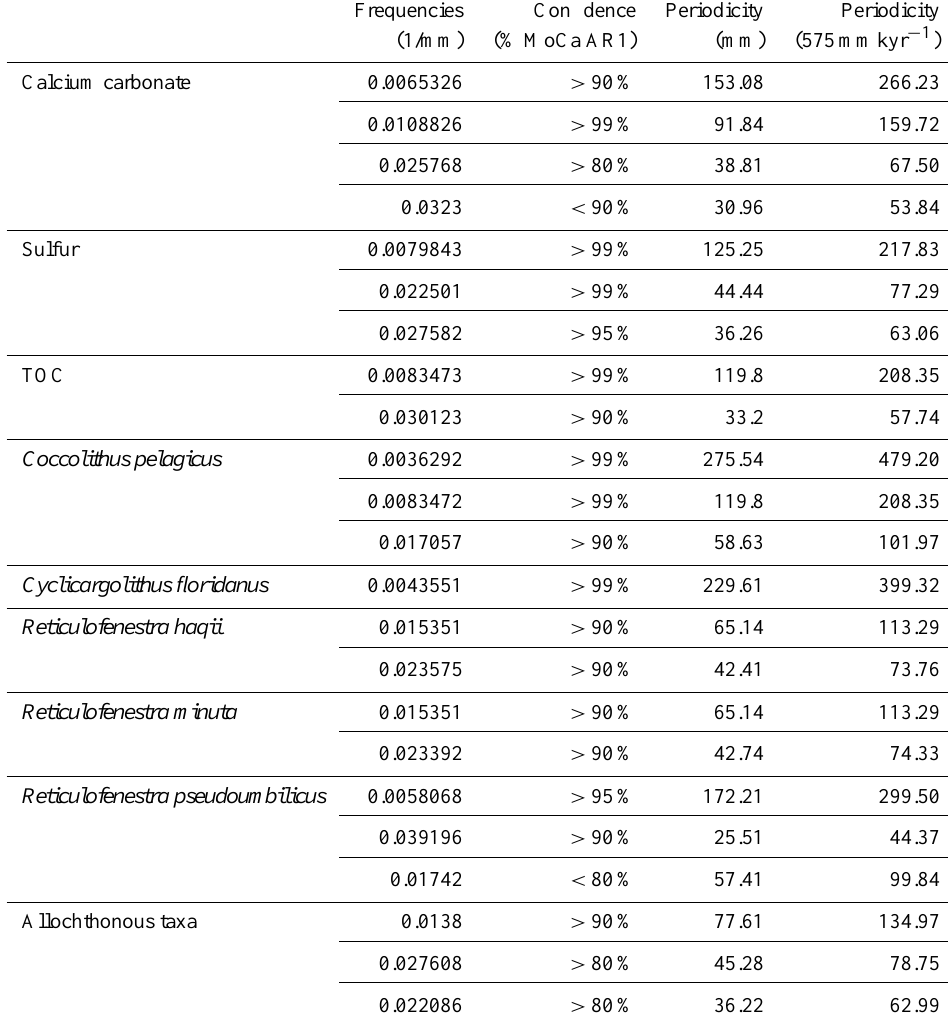
Table 3. Summary of results of the REDFIT analysis for the nine analyzed proxies. Table shows the detected frequencies, their confidence intervals (Monte Carlo corrected), and the resulting periodicity in millimeters. Periodicities in millimeters were then transformed into